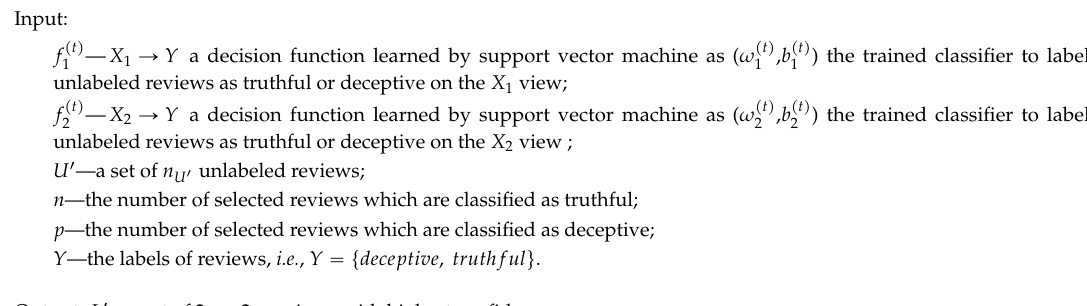
Algorithm 2. The CoSpa-C